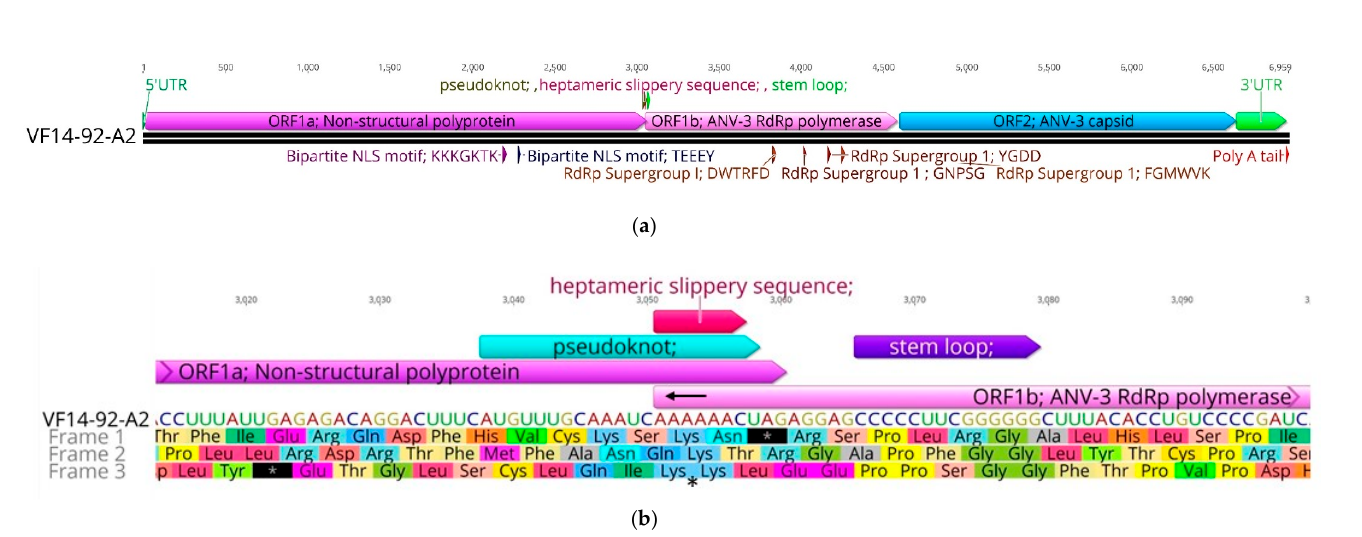
Figure 1. Schematic representation of ANV genotype 3 whole genome and ribosomal shift mechanism. ( a ) Schematic representation of ANV genotype 3 whole genome structural organisation comprising a partially overlapping open reading frame 1a (ORF1(a) and ORF1b and separate ORF2. Motifs and secondary structures located in ORF1a nuclear localisation signal NLS) bipartite KKKGKTK and TEEEY, ORF1b RdRp motifs DWTRFD, GNPSG, YGDD, and FGMWVK. ( b ) Schematic representation of the partially overlapping and –1 (signified by an arrow) ORF1a and 1b ribosomal frameshift signal with mapped pseudoknot, heptameric slippery sequence, and stemloop. The lysine amino acid (K) in frame 3 where translation recommences after the ribosomal frameshifting signal (RFS) is marked as *.